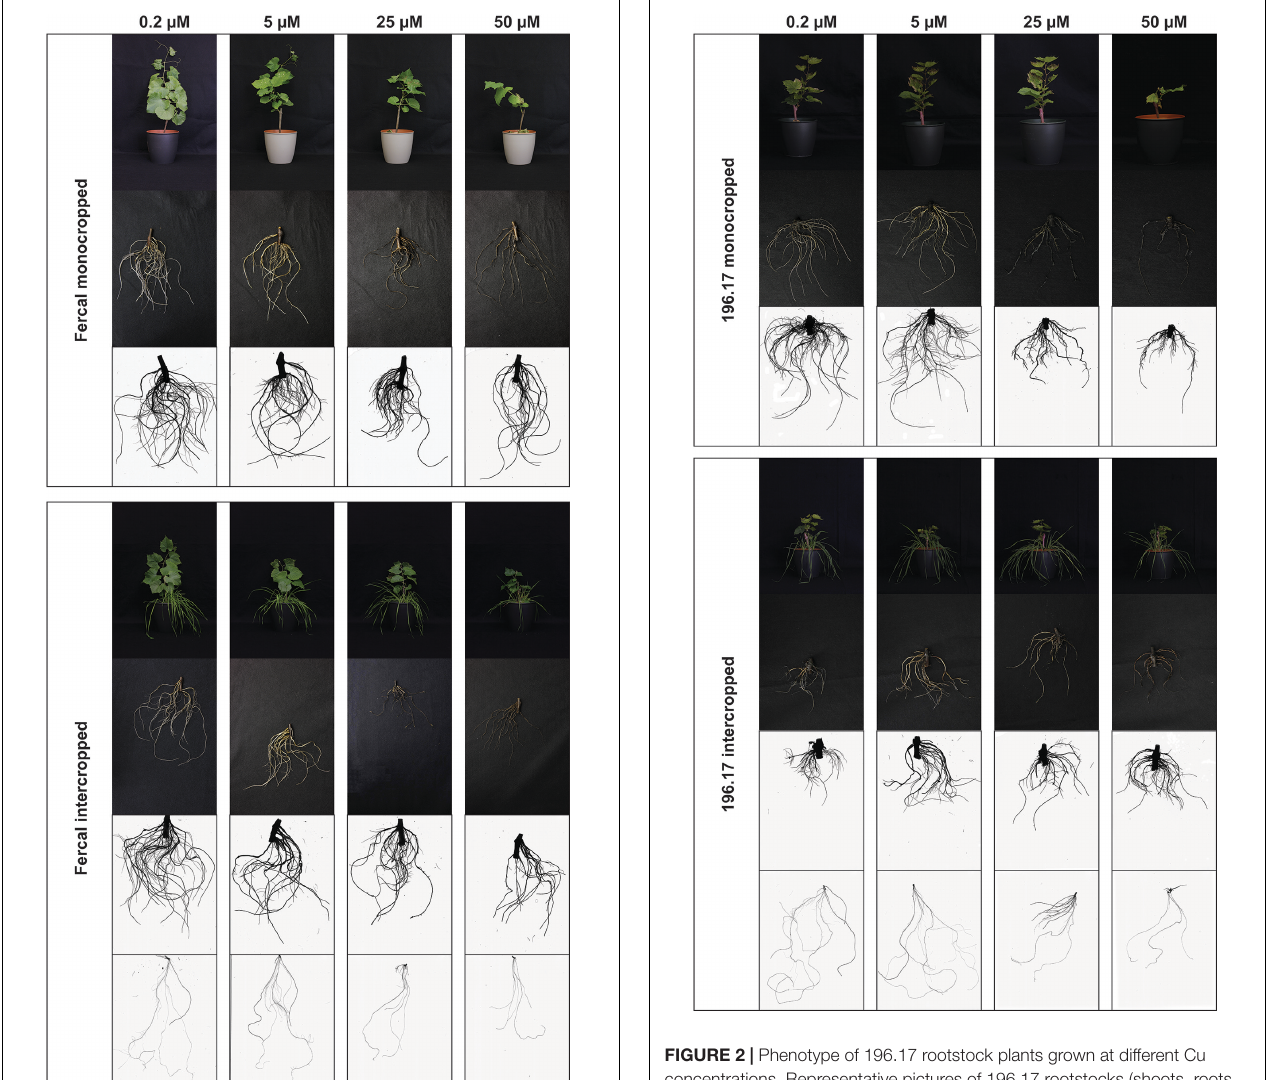
FIGURE 2 | Phenotype of 196.17 rootstock plants grown at different Cu concentrations. Representative pictures of 196.17 rootstocks (shoots, roots, and a representative WinRhizo Scan of the root apparatus) in both growing conditions (mono- and intercropping) at different concentrations of Cu (0.2–5–25–50 µ M). When presenting intercropping condition, also a representative WinRhizo Scan of oat root apparatus is shown. Pictures have been taken at harvest, i.e., 14 days after Cu